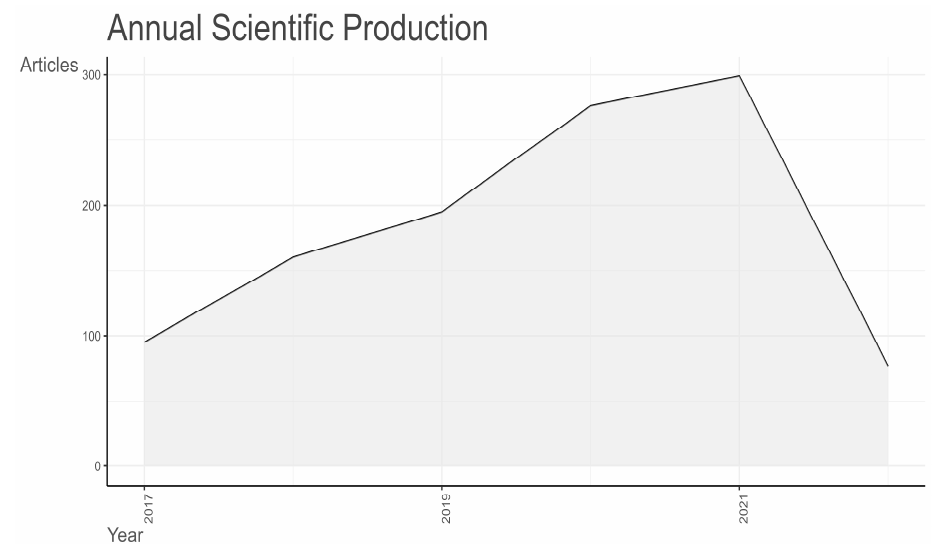
Figure 3. Production growth of research articles relating to flood prediction tools.